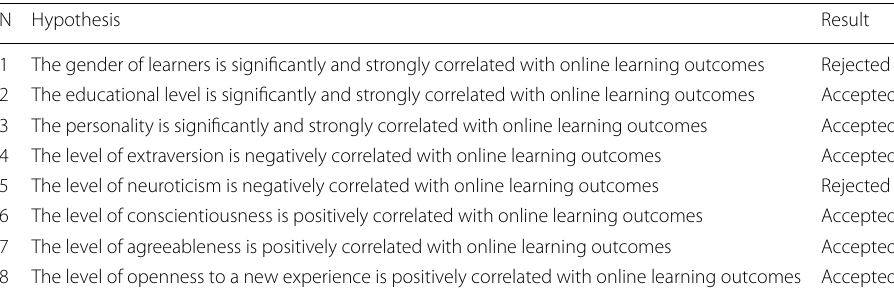
Table 4 Results of hypothesis testing N